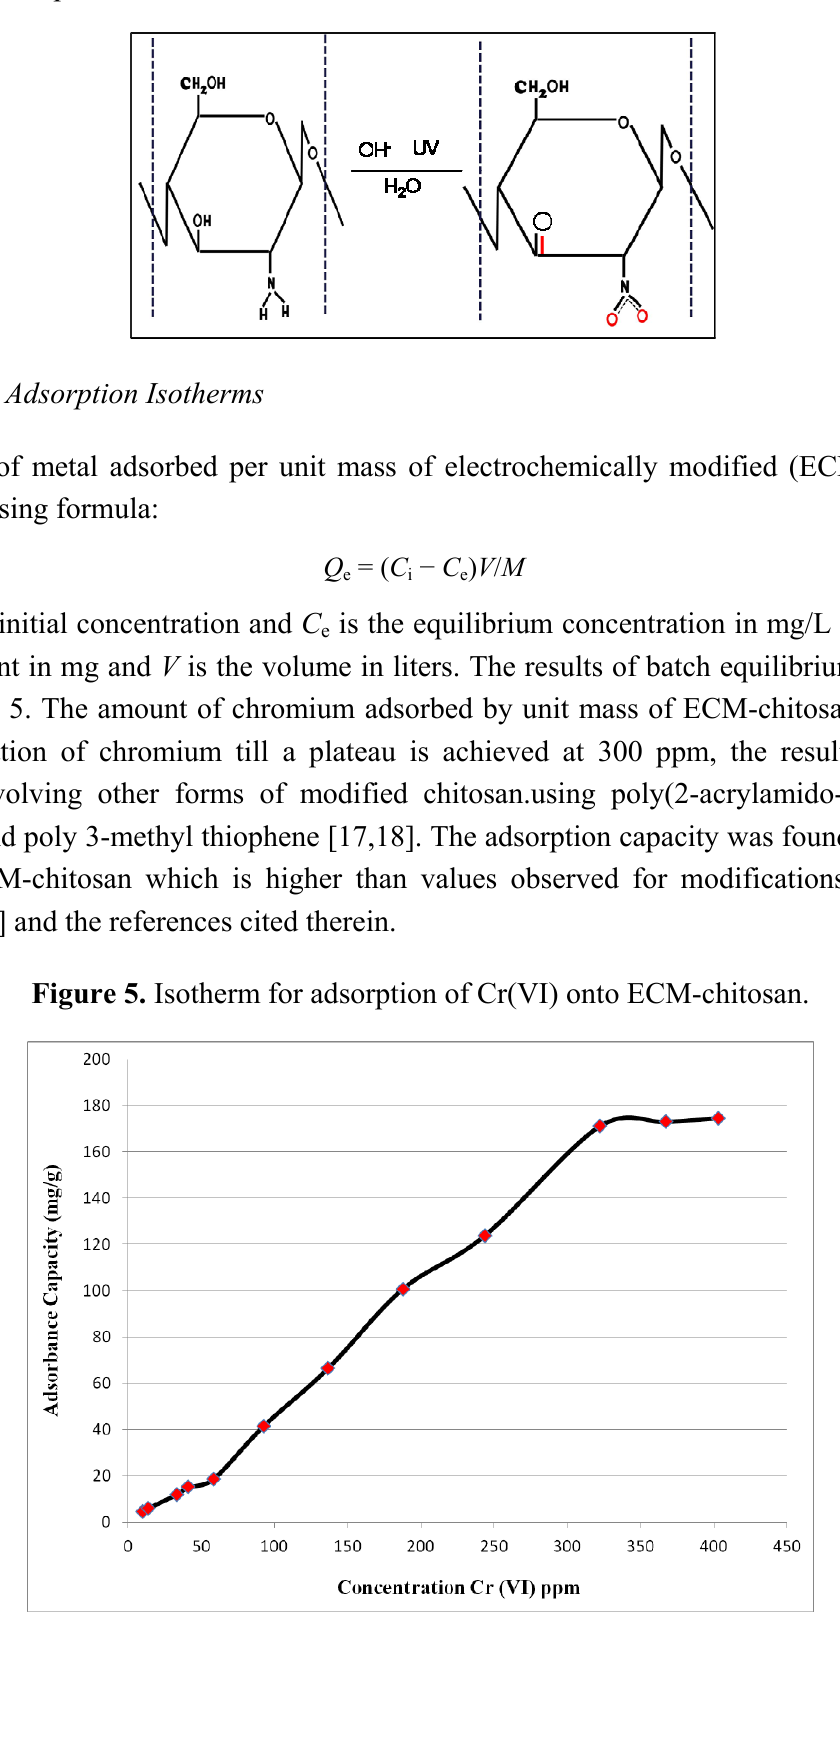
Figure 4. Structures of chitosan and nitro-chitosan synthesized by electrochemical deposition and photochemical oxidation.